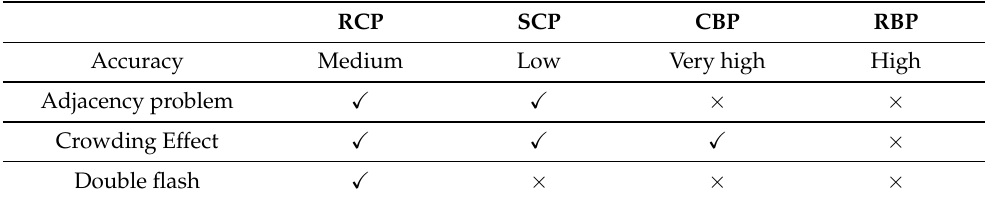
Table 1. P300 paradigms